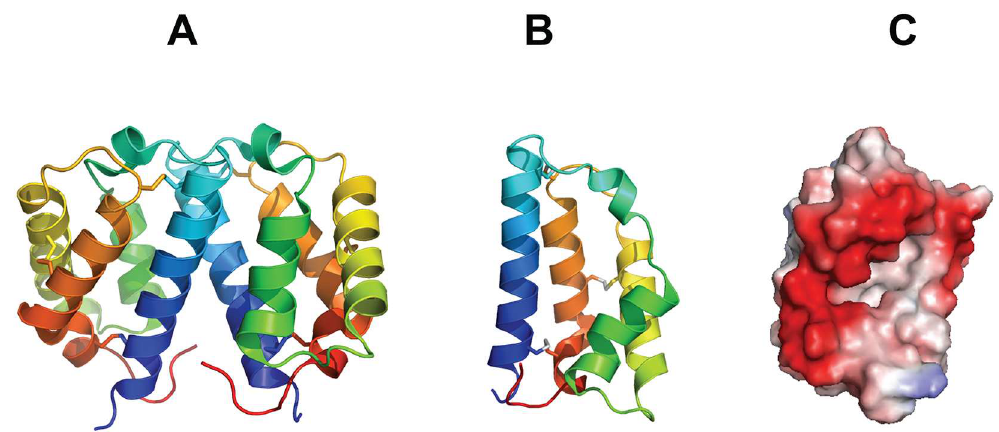
Fig 3. Crystal structure of SALO. A) Ribbondiagram of a SALO dimer with each monomer represented in rainbowcolors from the N-terminus (blue) to the C-terminus (red). B) Ribbondiagram of a SALO monomer. C) Chargedistributionon the surface of a SALO monomerin the same view as B.